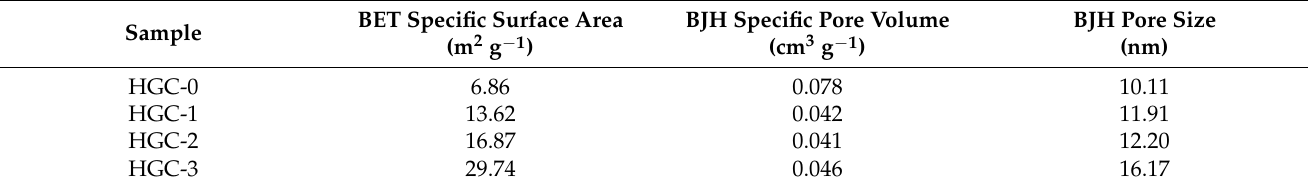
Table 1. Surface and pore structural parameters of the different